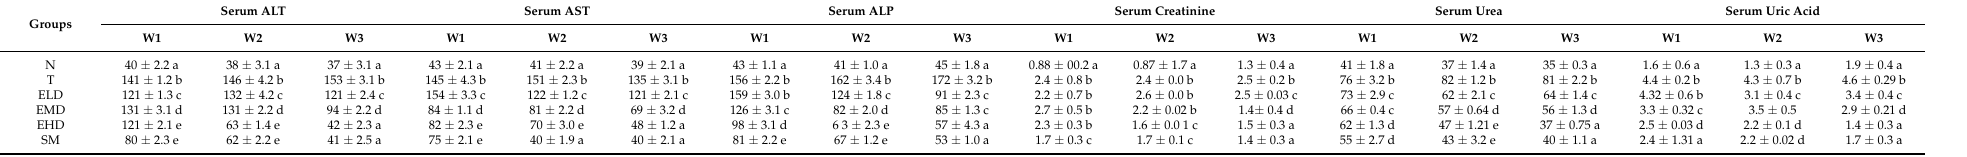
Table 3. The effects of (DO.AQ) extracts on serum biochemical markers of various experimental groups.